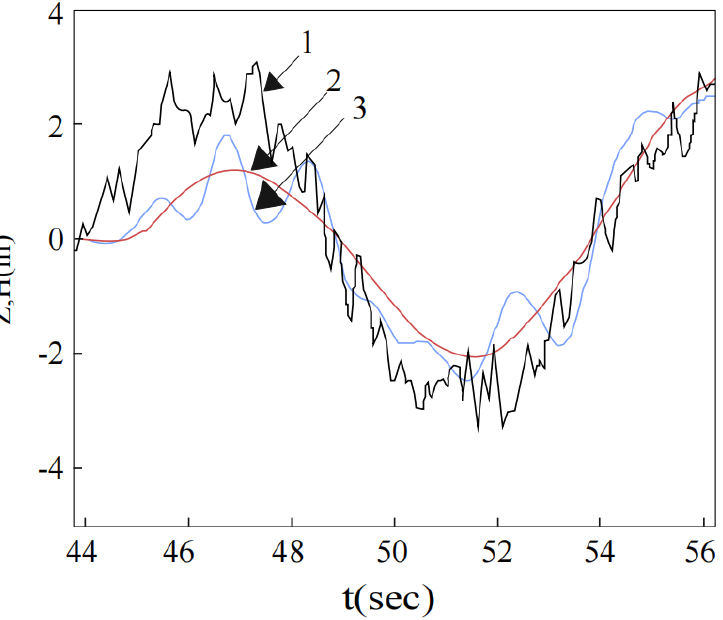
Figure 13. The response curve of aircraft’s tracking deck motion after introducing deck motion predictor and compensator.